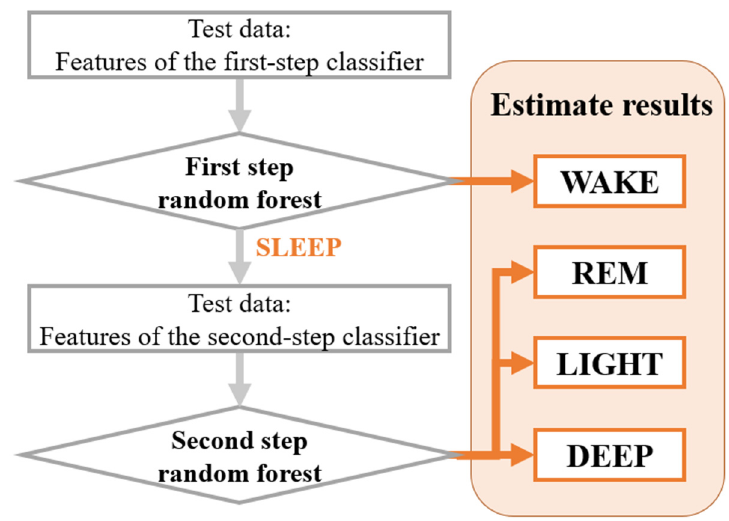
Figure 3. Two-step estimation method.